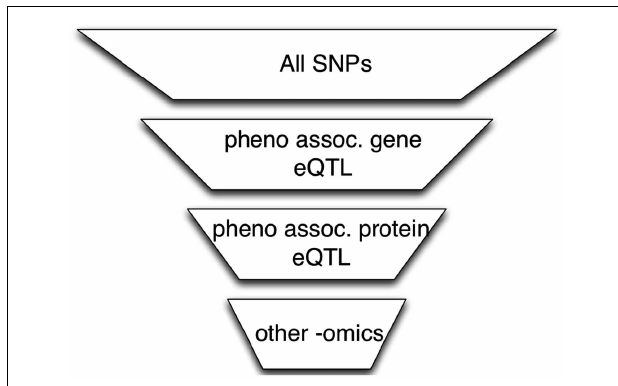
FIGURE 2 |The “triangle” method for integration of genotype, gene expression, and phenotype data. Through a series of steps, heterogeneous datasets, involving SNPs, gene expression and trait are integrated. At each step, a p -value threshold is applied. In general, the p -value threshold used is arbitrary; in practice, the choice allows for prioritization of genes or SNPs.The result of the triangle method is a set of SNP association p -values (represented by the “obs p ” in the